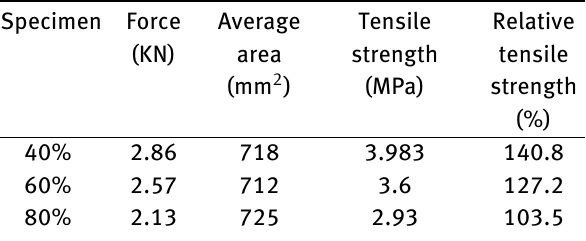
Table 18: Tensile strength for geopolymer mortar reinforced with 1%